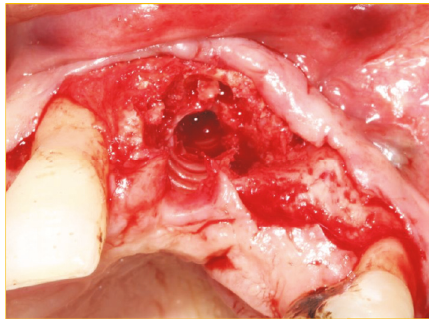
Figure 8: The implant has been simply “unscrewed” with minimal removal torque applied via Adams Orthodontic Pliers.